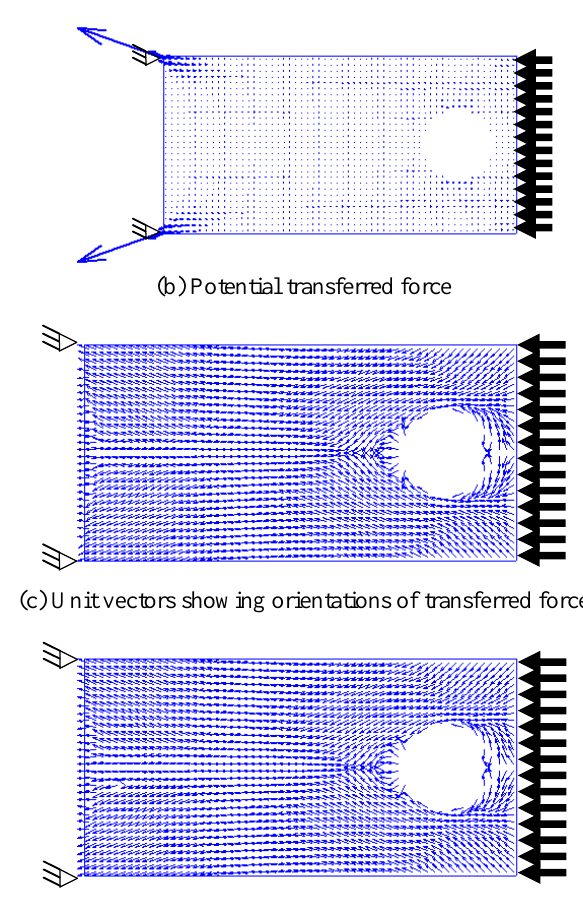
tions ntia Fig. 27. Transferred and ra force to th reaction points with a hol trib ing in the st